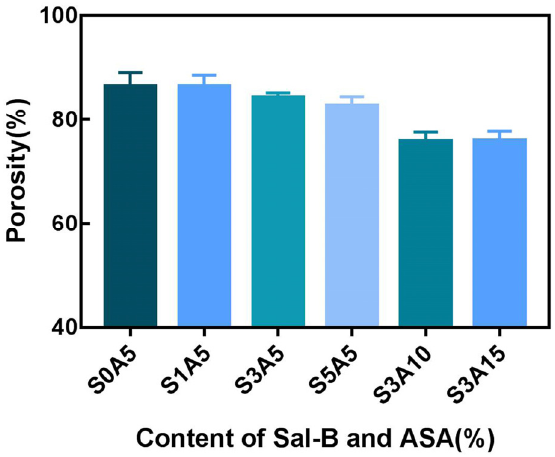
Figure 6. Porosity of dual drug ‐ loaded biomimetic composite scaffold.